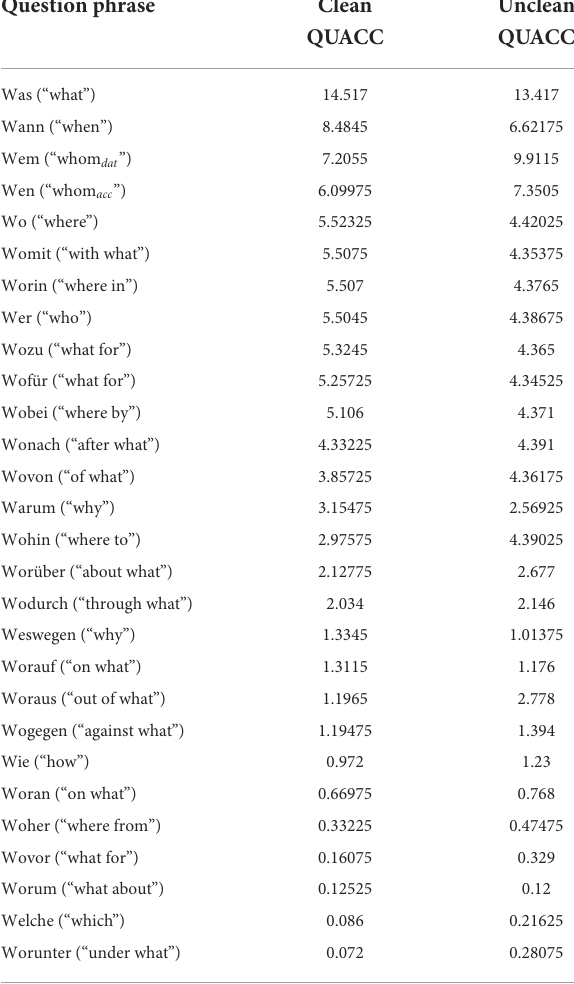
TABLE 1 Types and percentage of question phrases in QUACC data